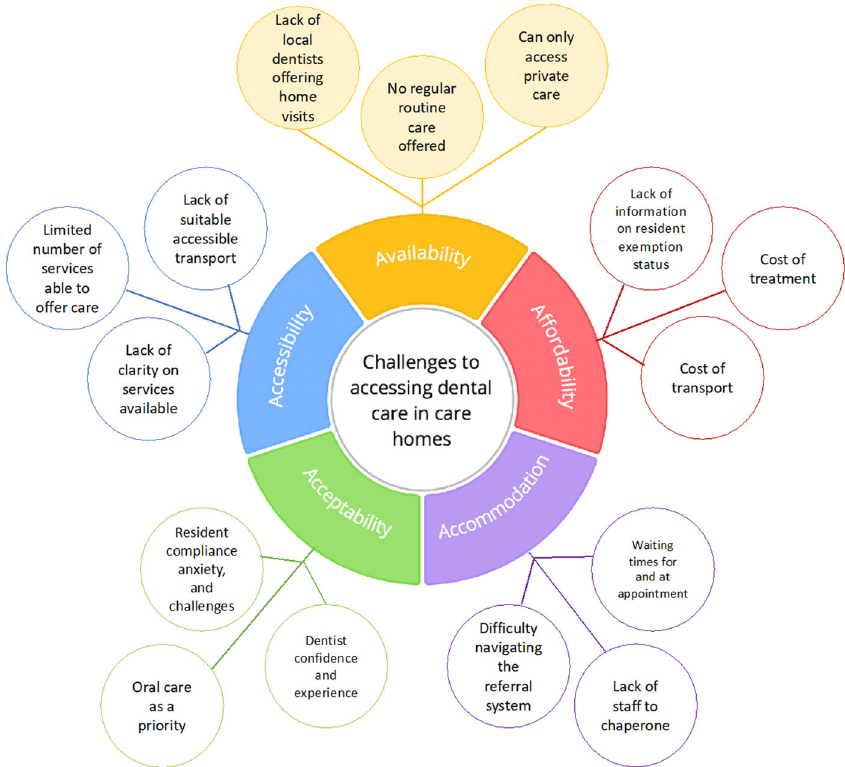
Fig. 1 Image depicting the challanges to accessing dental care for care home residents mapped to Penchansky and Thomas ’ s theory of access to care (1981) domains. These include challanges of individual and organisation priorities, barriers and facilitators as well